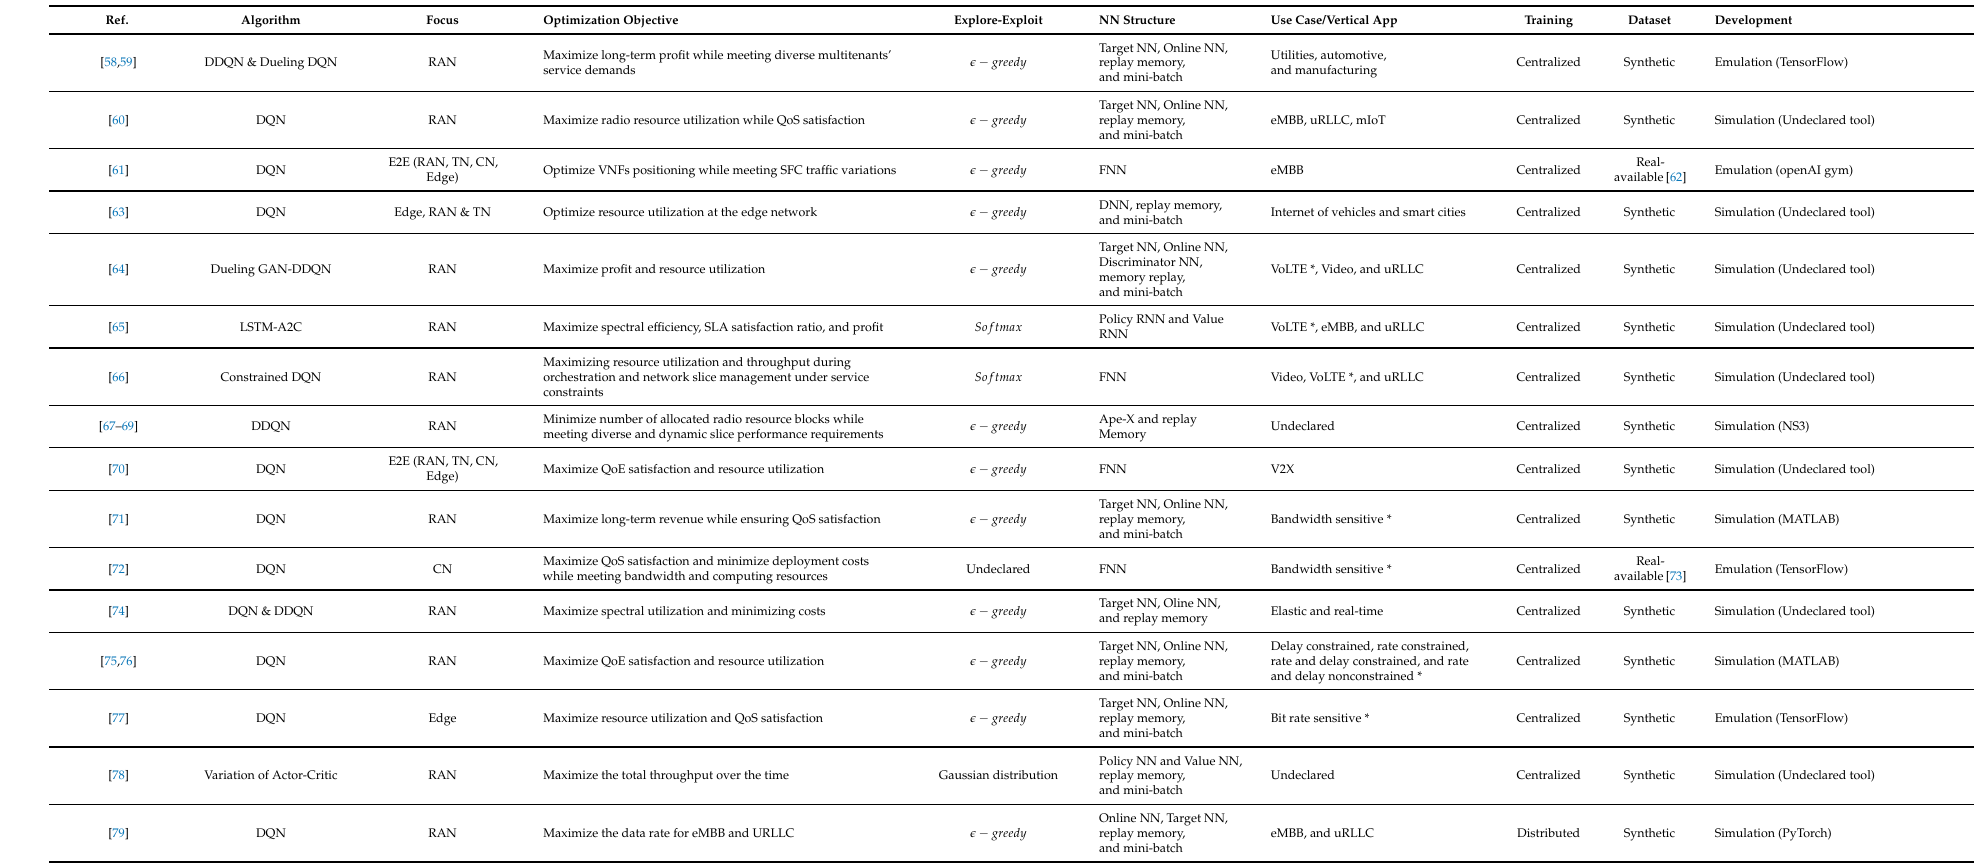
Table 3. Resource allocation based on